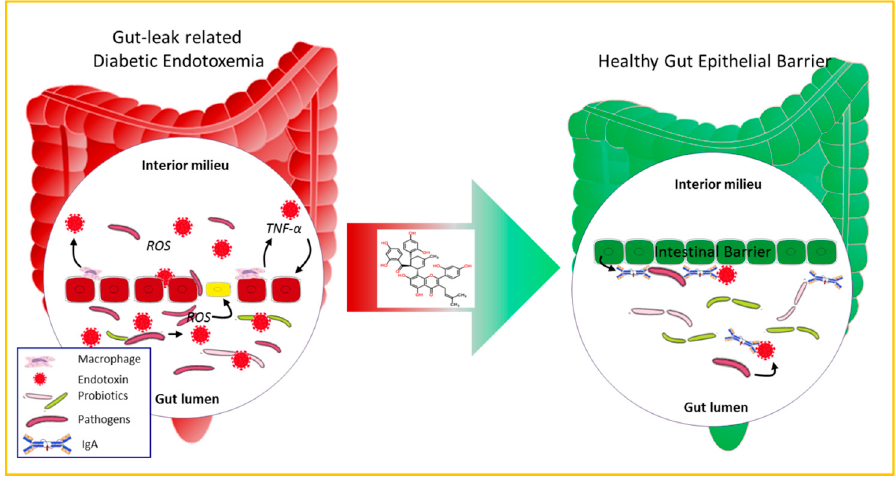
Figure 8. Mechanism of KWG on protecting gut epithelial barrier integrity.